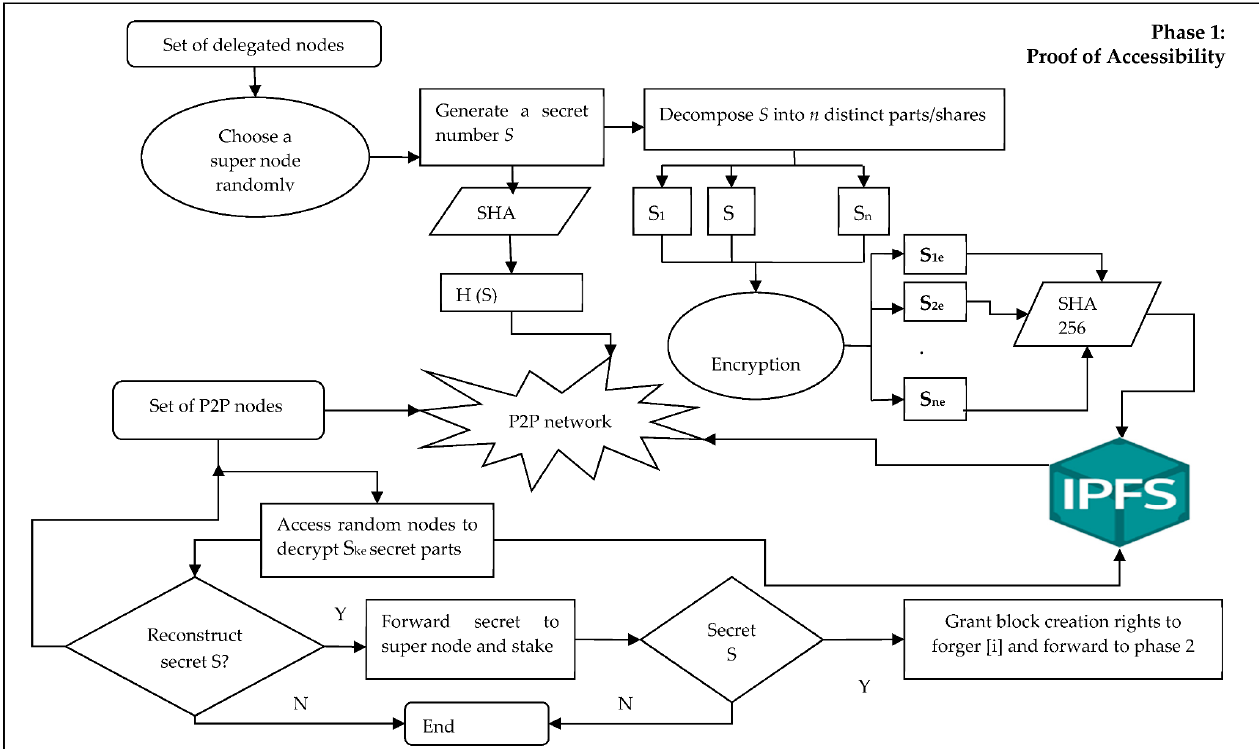
Figure 4. Proposed consensus algorithm (Phase 1).